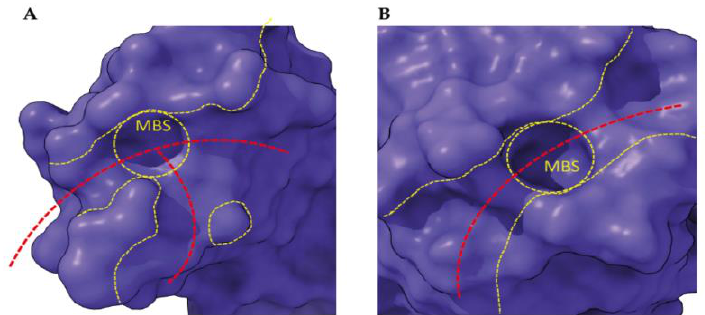
Figure 6. Molecular surface of the top of HPA ( A ) and Morniga G ( B ) monomer: The topographical organization of the surface surrounding the monosaccharide-binding site/pocket (delineated by a yellow dashed circle) is shown. The red dashed lines define the axes along which additional sugar units linked to the sugar occupying the monosaccharide-binding site (MBS) could be accommodated by hydrophilic and hydrophobic residues forming the extended CBS located around the MBS. The regions surrounding the MBS susceptible to accommodating branched O-glycans are delineated by yellow dashed lines.